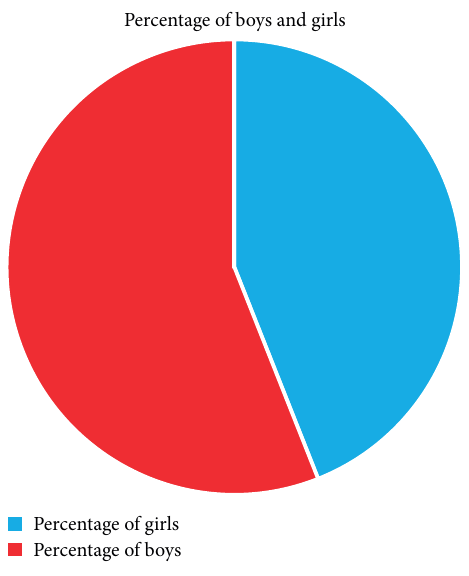
F IGURE 1: The percentage of girls and